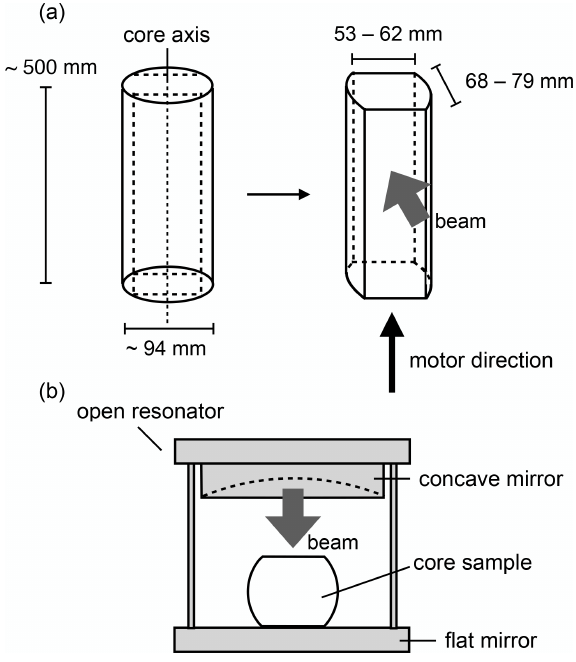
Figure 2. Diagrams of the (a) core cutting geometry and (b) exper- imental set-up (viewed from the front).